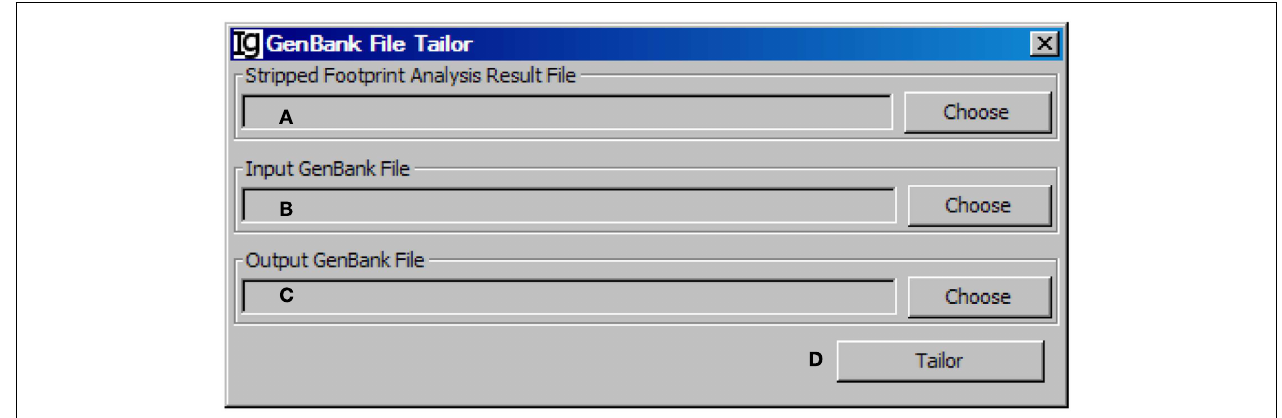
FIGURE 12 |The GenBank file tailor . Diagram shows the interface of the GenBank FileTailor. (A) Button to choose the footprint analysis result file. (B) Button to choose the input GenBank file for tailoring. (C) Button to choose the output file. (D) Button to start the tailoring process.